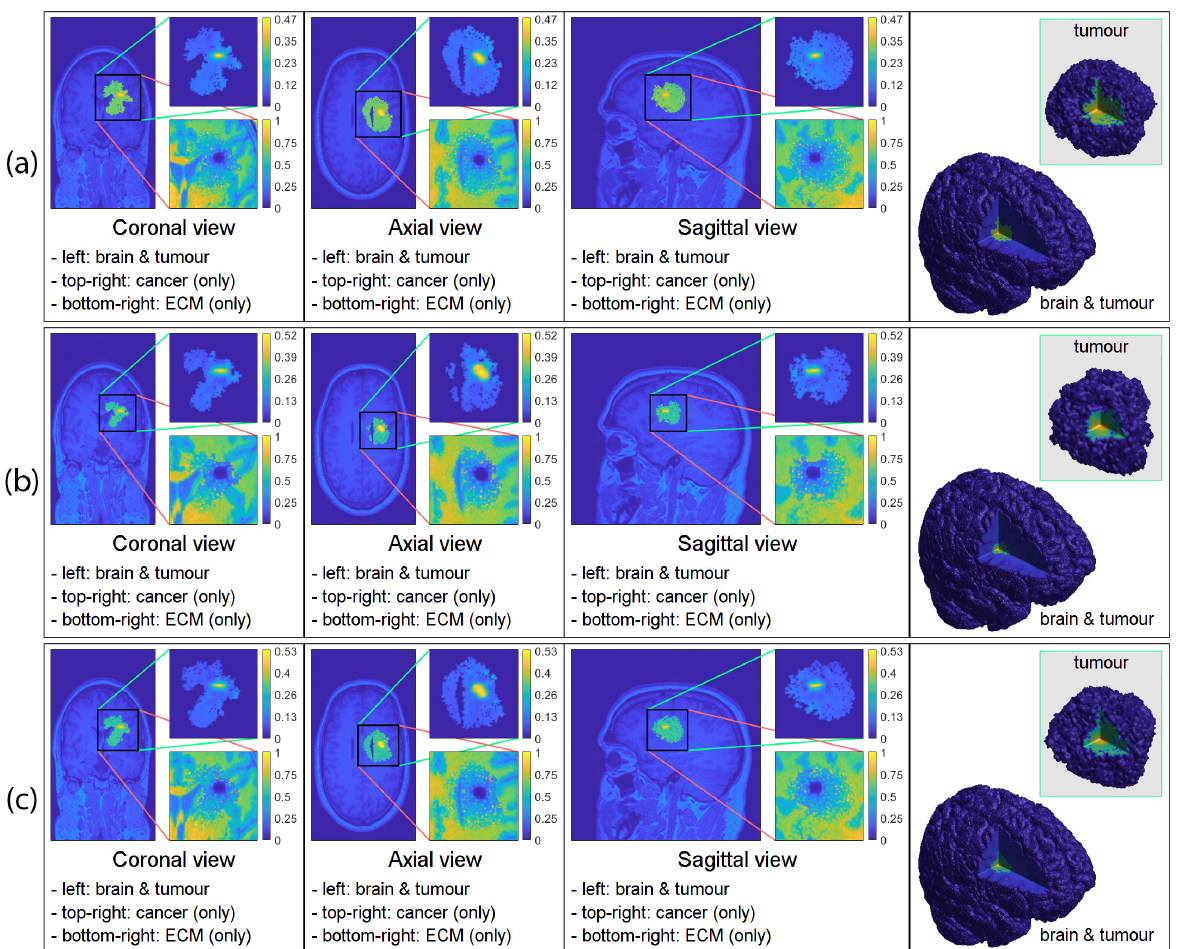
Figure 3. 3D computer simulation results: ( a ) with only white-grey matter dependency ( r = 1), ( b ) with only DTI data used ( D G = 1), ( c ) with both white-grey matter dependency and DTI data incorporated. To present the simulations, we divide each result into four panels: coronal, axial, sagittal and 3D view. Within each coronal, axial and sagittal views, we show the tumour embedded within the brain on the left, the cancer cell density on the top-right and the ECM density on the bottom-right. In the 3D view (the furthest right panel in each result) we show the cross-section of the whole brain with the tumour on the bottom-left corner and on the top-right corner we show the isolated